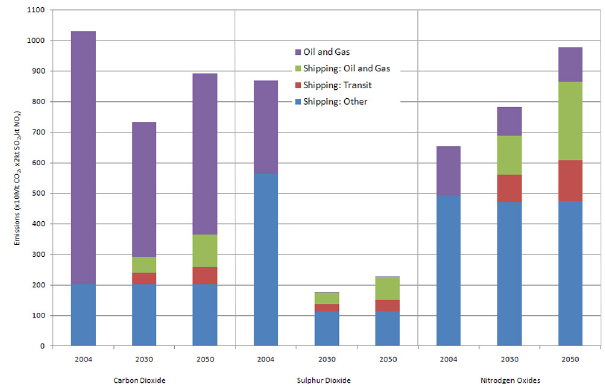
Fig. 5. A comparison of the different emission sources in the Arc- tic region for CO 2 , SO 2 , and NO x (based on the data in Table 6). The “Other Shipping” is not based on calculations performed in the paper. Note the different scales: CO 2 is × 10Mt CO 2 , SO 2 is × 2kt SO 2 , and NO x is kt NO x